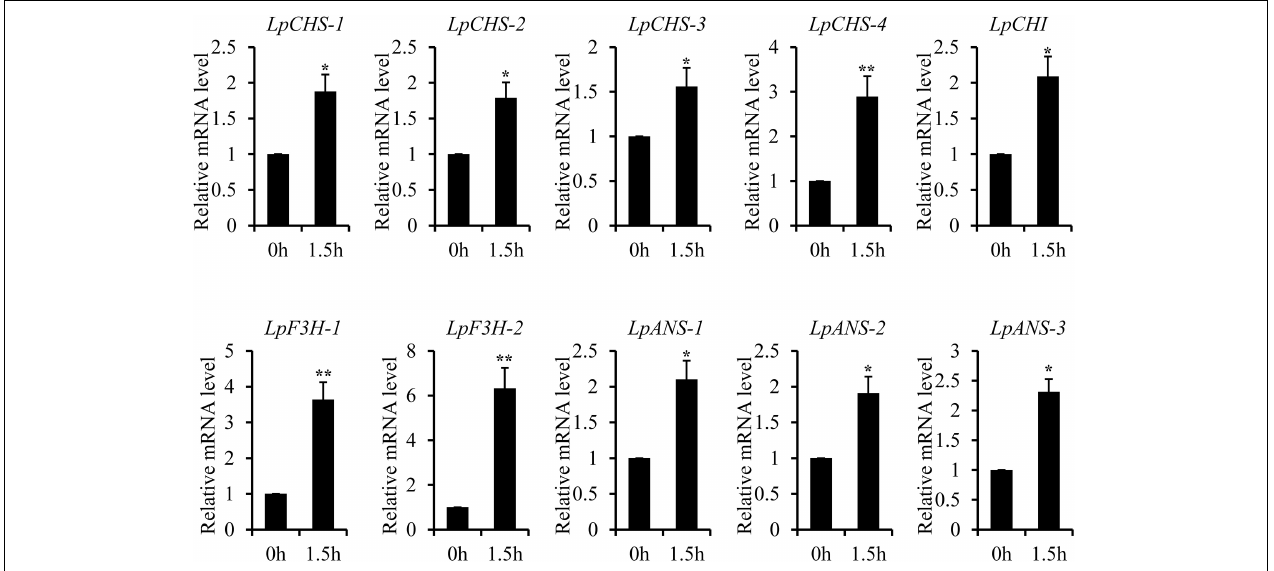
FIGURE 8 | Key enzyme genes of flavonoid synthesis pathway were up-regulated after UV-B treatment. The gene expression levels were analyzed by quantitative RT-PCR analysis; the Y-axis indicates the relative expression level; the X-axis indicates UV-B treatment time (h); The data were calculated from three biological replicates. Vertical bars are means ± SE. Significant difference (* P < 0.05, ** P < 0.01).